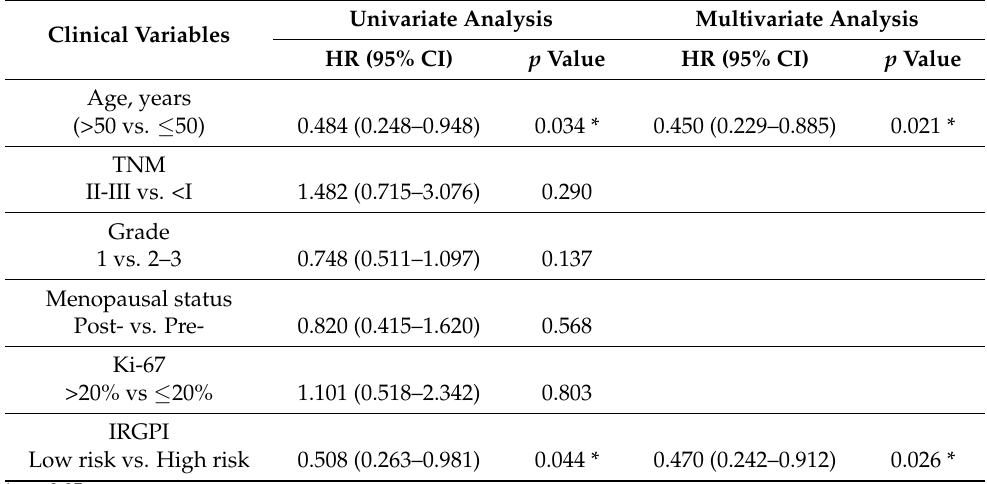
Table 2. Univariate and Multivariate Cox analysis of prognostic factors for TNBC patients from our hospital.